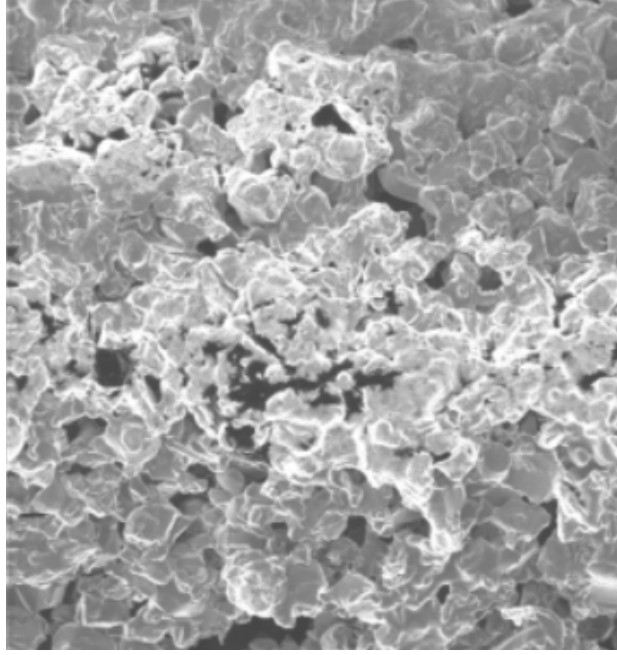
Figure 14. FIB micrograph of cross-sectional view of MnZn ferrite sample.